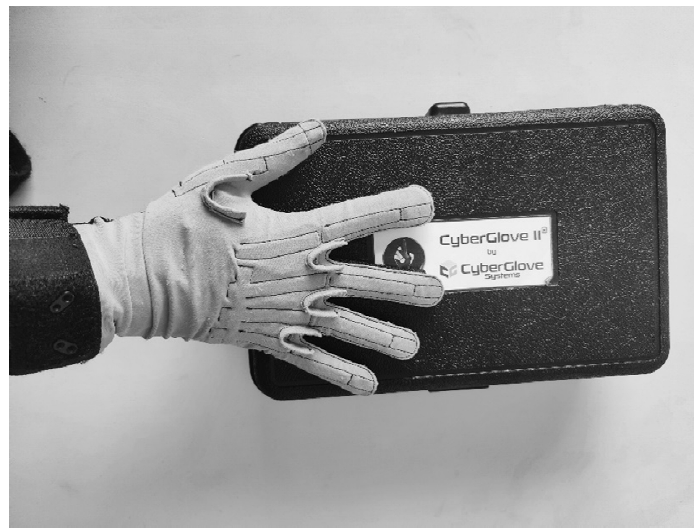
Figure 1. A participant wearing the CyberGlove II ® .